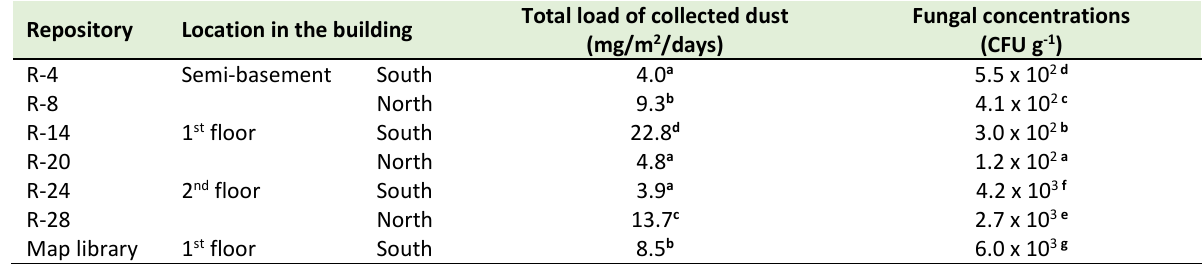
TABLE 4. Total load of dust collected in the studied repositories and fungal concentrations detected in them.